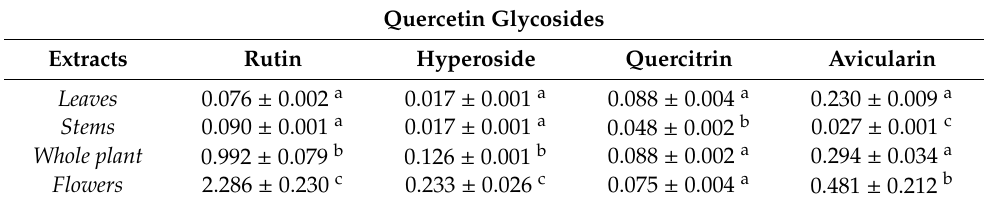
Table 1. Quantitative composition (mg/g of DW) of determined quercetin glycosides in E. ciliata ethanolic extracts.